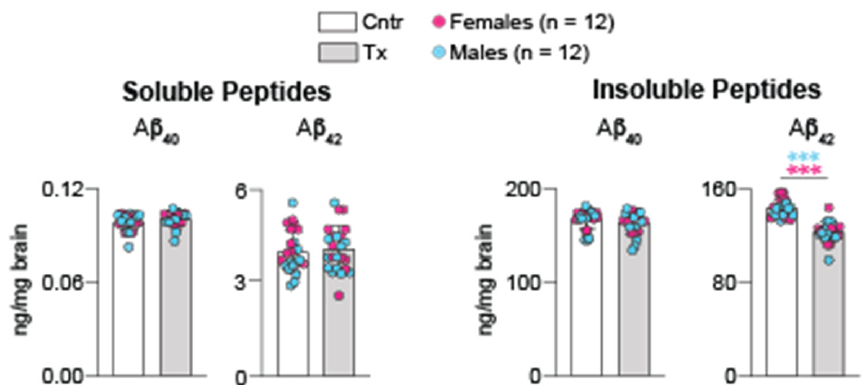
Figure 2. 8,14-DihydroxyEFV effect on the brain A β peptides. Data represent the mean ± SD of the measurements in individual 5XFAD mice (12 female and 12 male). *** p ≤ 0.001 as assessed by two-way ANOVA with Tukey’s multiple comparison test. The asterisk color indicates significance between female mice (pink) and male mice (blue). Cntr, control mice; Tx, treated mice.